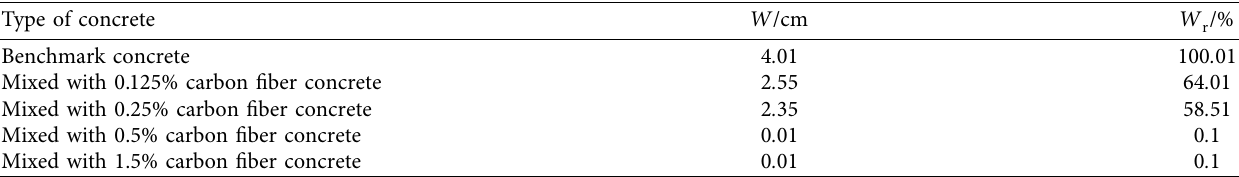
Table 4: Efect of carbon fber content on drying shrinkage cracking in the early stage of hardening.